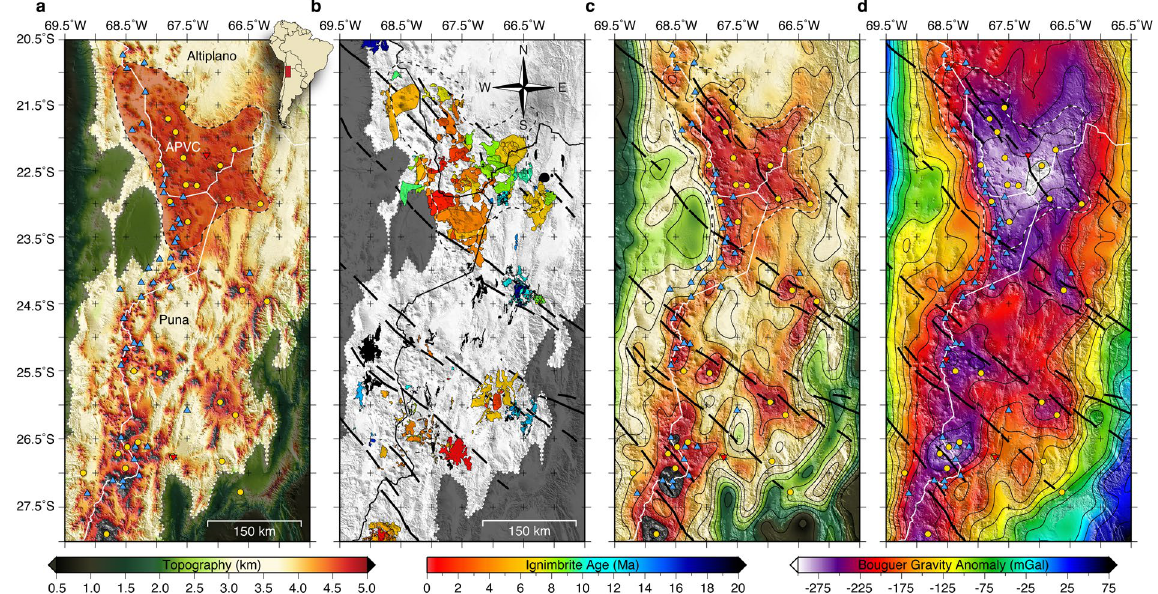
Figure 1. ( a ) Study area map within the Central Andean Plateau (CAP; < 3 km masked) with the Altiplano- Puna Volcanic Complex (APVC) separating the Altiplano basin (northern CAP) and the high-relief Puna Plateau (southern CAP). Blue triangles show Holocene age volcanism of the Central Volcanic Zone (CVZ), gold circles show known ignimbrite eruption calderas, and inverted red triangles show INSAR measured vertical surface deformation centers 28 . ( b ) Distribution of Neogene ignimbrite deposits; black lines show the location of transverse lineaments 11, 59 . ( c ) Long-wavelength ( > 50 km) topography. ( d ) Long-wavelength ( > 50 km) Bouguer gravity anomalies 60 . These plots were made using the Generic Mapping Tool 61 , version 4.5.1 (ftp://ftp.soest.